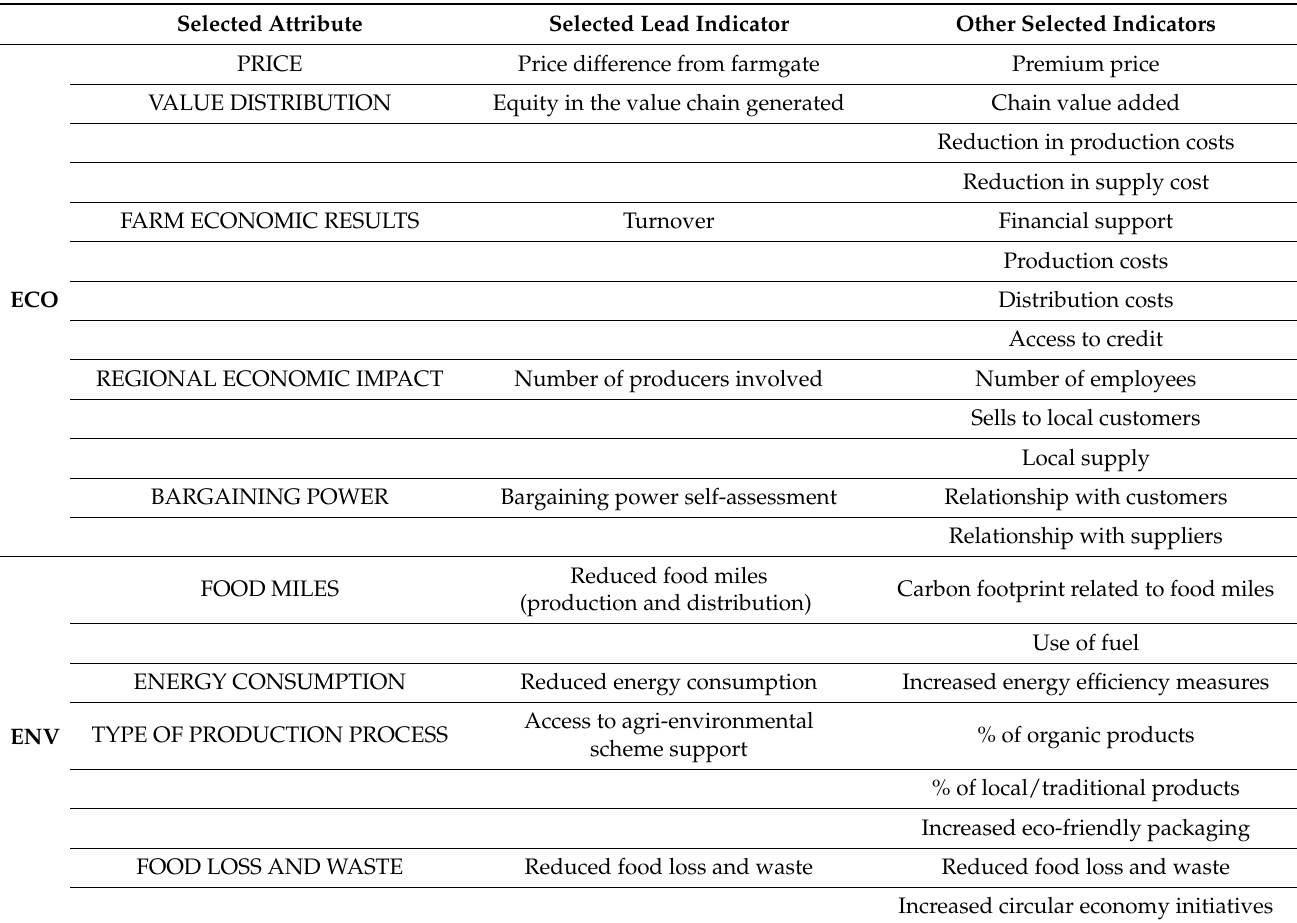
Table 5. Final set of SFSC sustainability attributes and